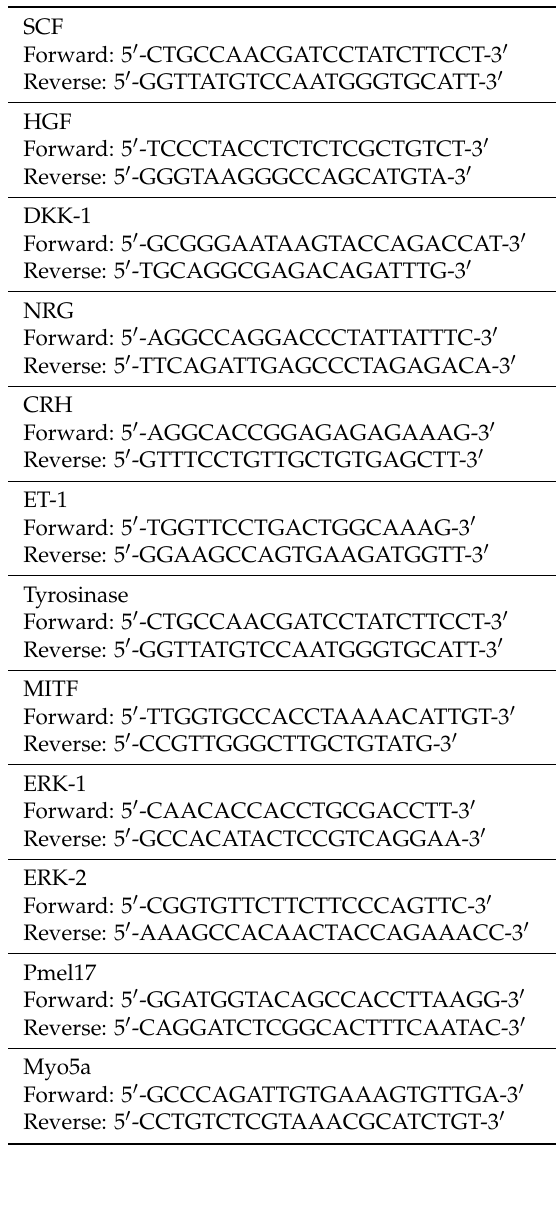
Table 2. The primer sequences used in this